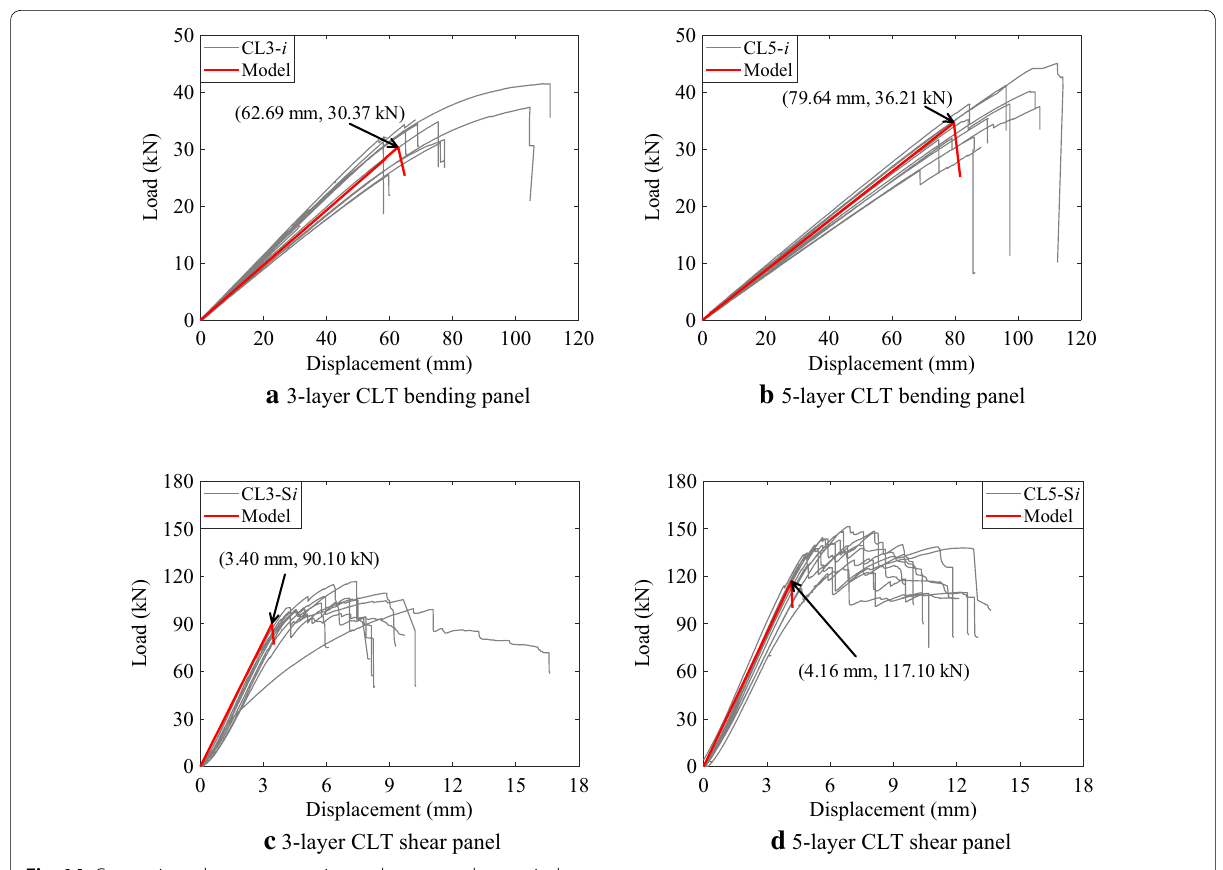
Fig. 14 Comparisons between experimental curves and numerical